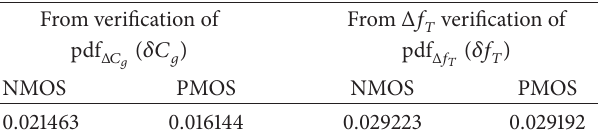
Table 2: K-S test statistics. From verification of From Δ𝑓 𝑇 verification